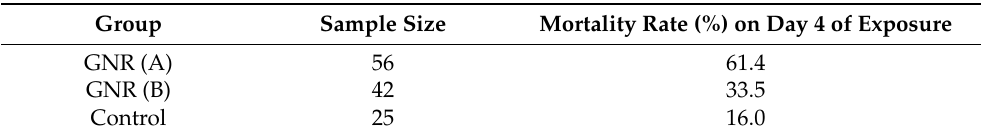
Table 1. The mortality rate of the chicken embryos upon treatment with GNR (A) and (B) compared to the control.